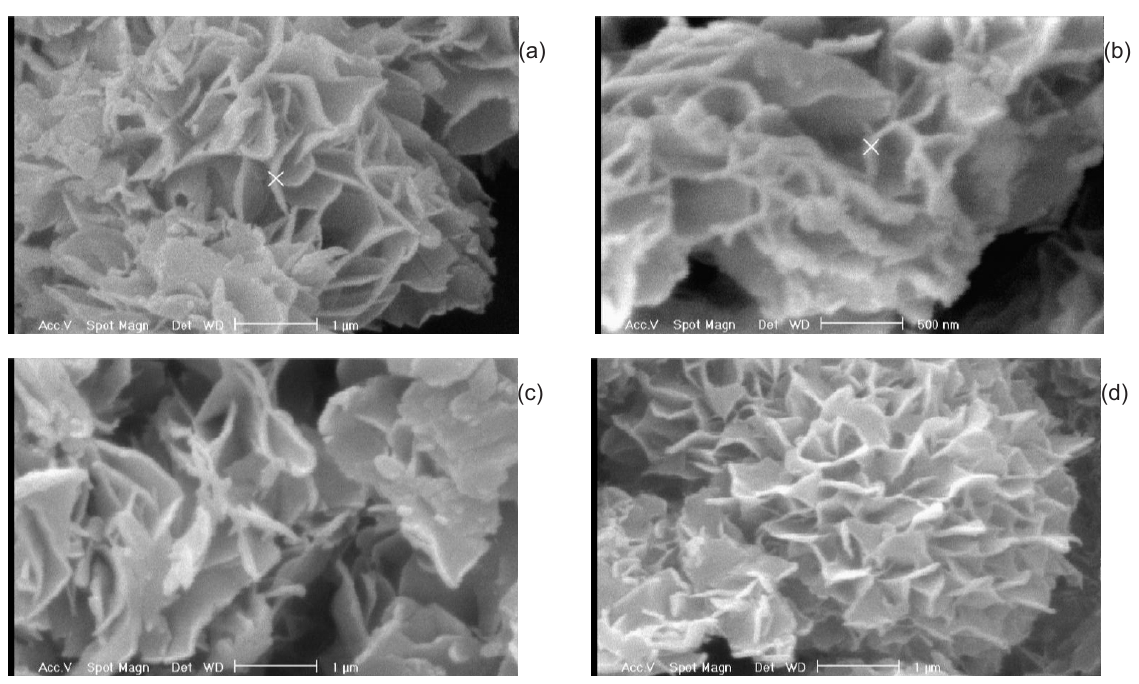
Figure 1. SEM images of MnWO nanoplates in flower-like clusters obtained under different runs by precipitation method: (a) run 1, (b) run 2, 4 (c) run 4, and (d) run 7. Table 2. ANOVA results for synthesis o MnWO particles via precipitation procedure using OA 4 plates (nm) are as responses.